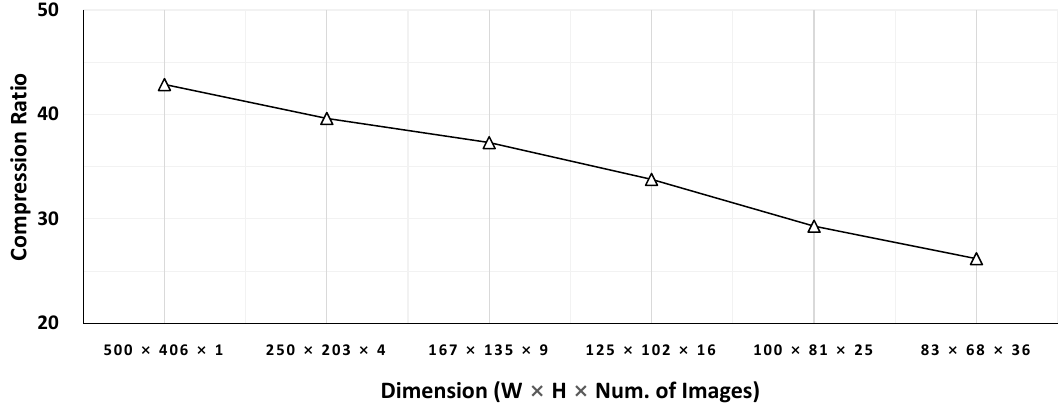
Dimension (W × H × Num. of Images) Figure 3. Impact on compression ratio due to